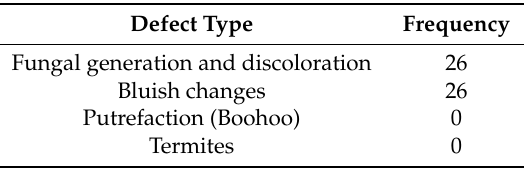
Table 7. Defects due to biological